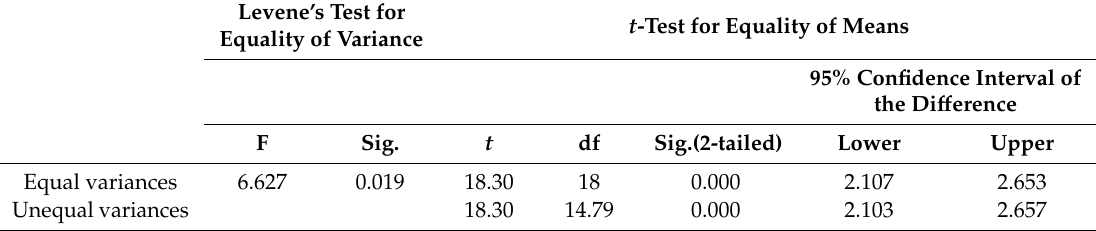
Table 9. Test statistics with the best